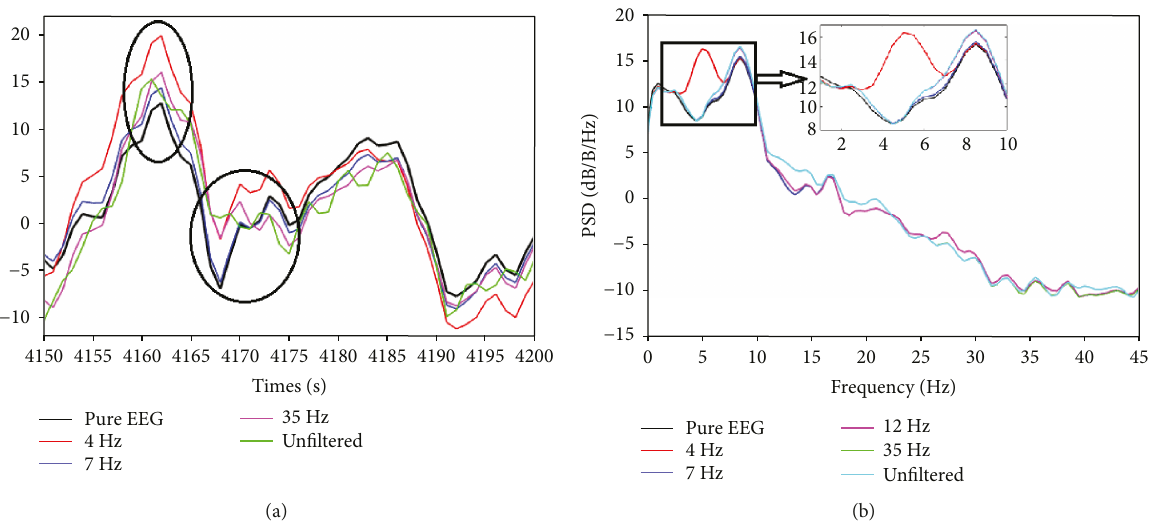
Figure 4: Analysis of bidirectional contamination by comparing reconstructed EEG obtained using di ff erent EOG low-pass fi ltering. (a) Time domain. (b) Frequency domain.